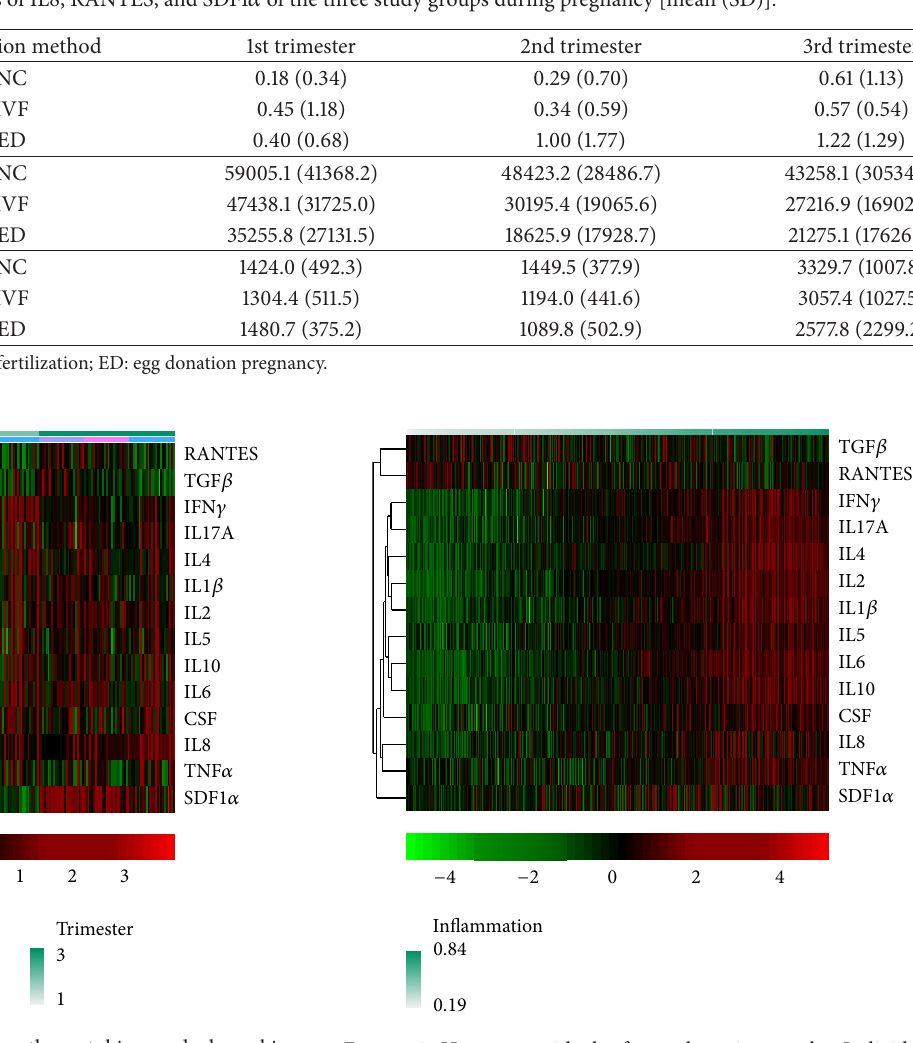
Figure 3: Heat map with the fuzzy clustering results. Individuals were ordered according to their GoM (grade of membership) score; a higher GoM score (red) denotes a higher inflammation status. TGF 𝛽 , transforming growth factor-beta; RANTES, regulated upon activation normal T-cell expressed and secreted; IFN 𝛾 , interferon- gamma; IL, interleukin 17, IL4, IL1 𝛽 , IL2, IL5, IL6, and IL10, GM- CSF, decidual granulocyte-macrophage colony-stimulating factor; IL8; TNF 𝛼 , tumor necrosis factor-alpha; and SDF1 𝛼 , stromal cell- derived factor 1